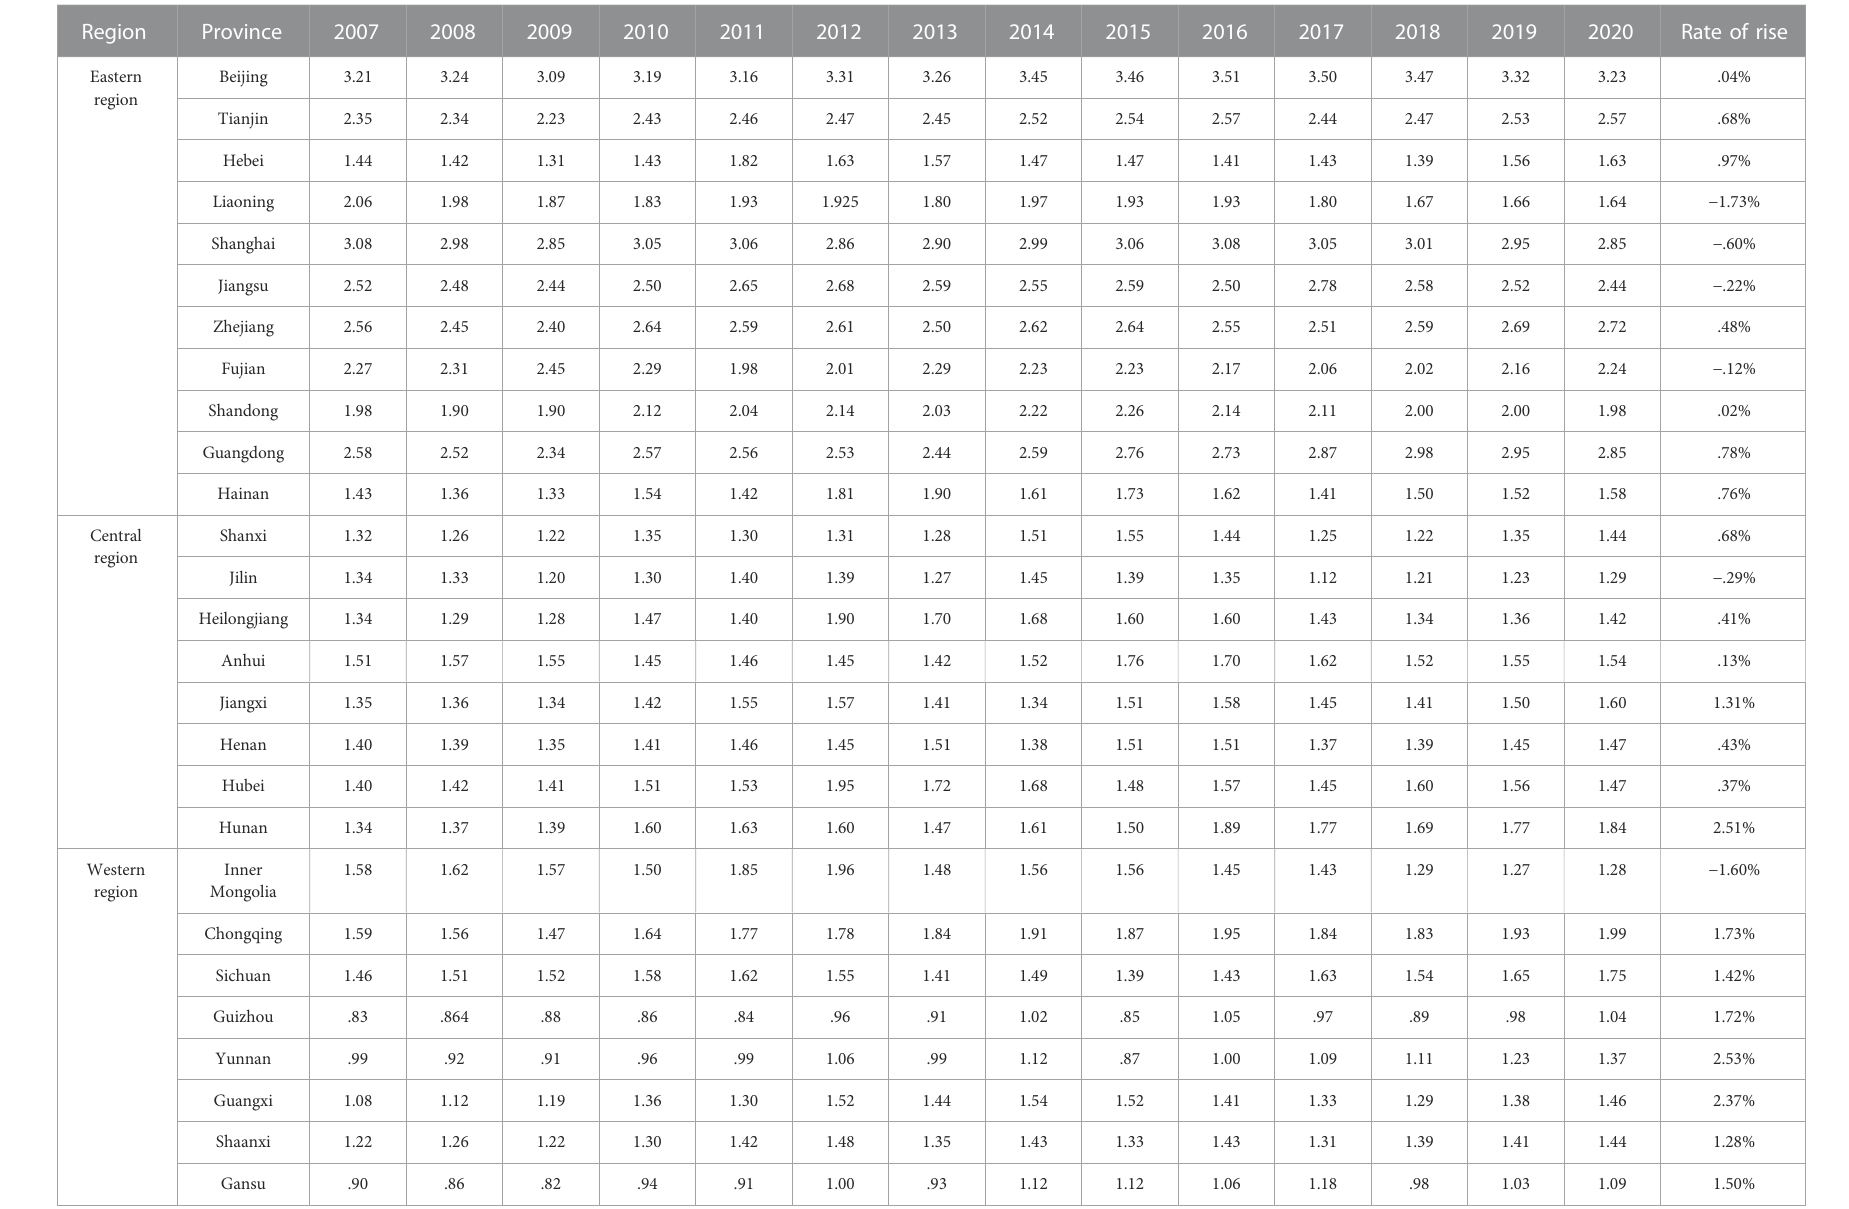
TABLE 3 DB environment scores of each province during 2007 –